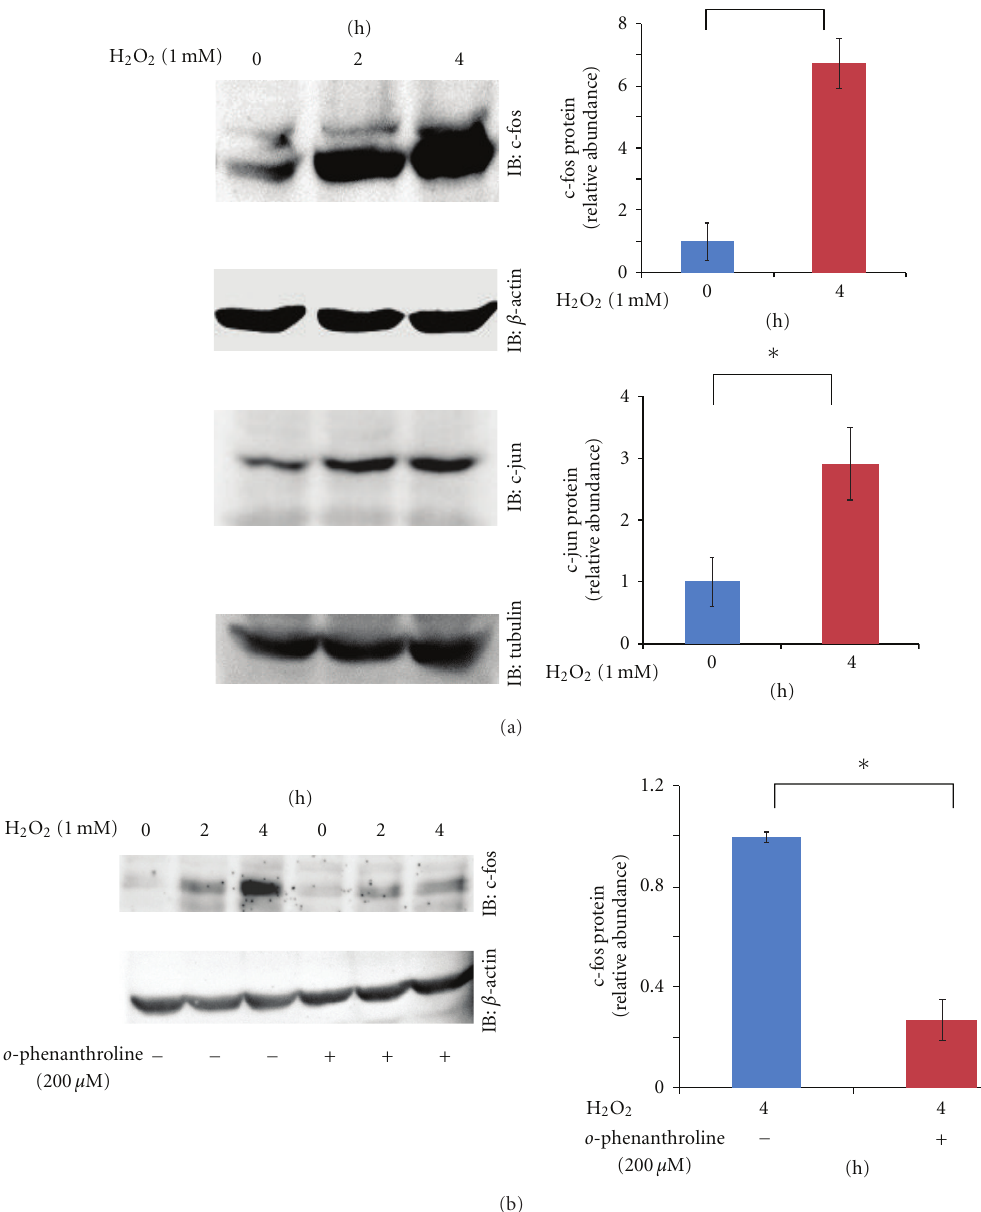
Figure 1: (a) Upregulation of AP-1 gene expression in SiHa cells at the indicated time points after H 2 O 2 (1mM) exposure. Representative blots are shown and include β -actin or tubulin as a loading control, along with the results of densitometric analysis (0h, 4 h; normalized to β -actin or tubulin). ∗ P < 0 . 05, n = 3. (b) Inhibitory e ff ect of o -phenanthroline on H 2 O 2 -induced c-fos upregulation. Cells were pretreated for 1 hour with or without o -phenanthroline (200 μ M) before H 2 O 2 (1mM) exposure. Representative blots are shown and include β -actin as a loading control, along with the results of densitometric analysis (4h; normalized to β -actin). ∗ P < 0 . 05, n =